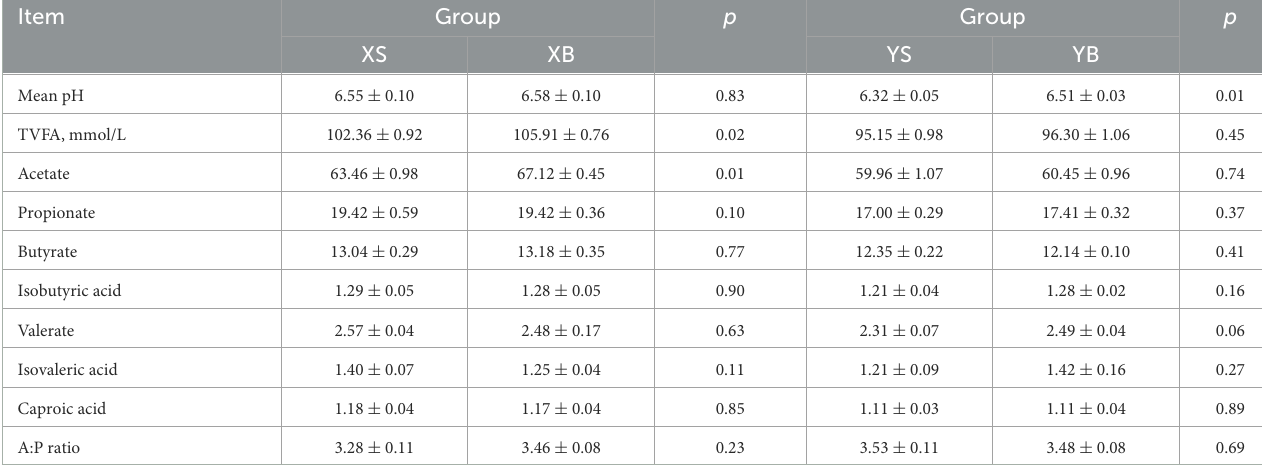
TABLE 4 Rumen fermentation parameters by sheep and goats fed the same